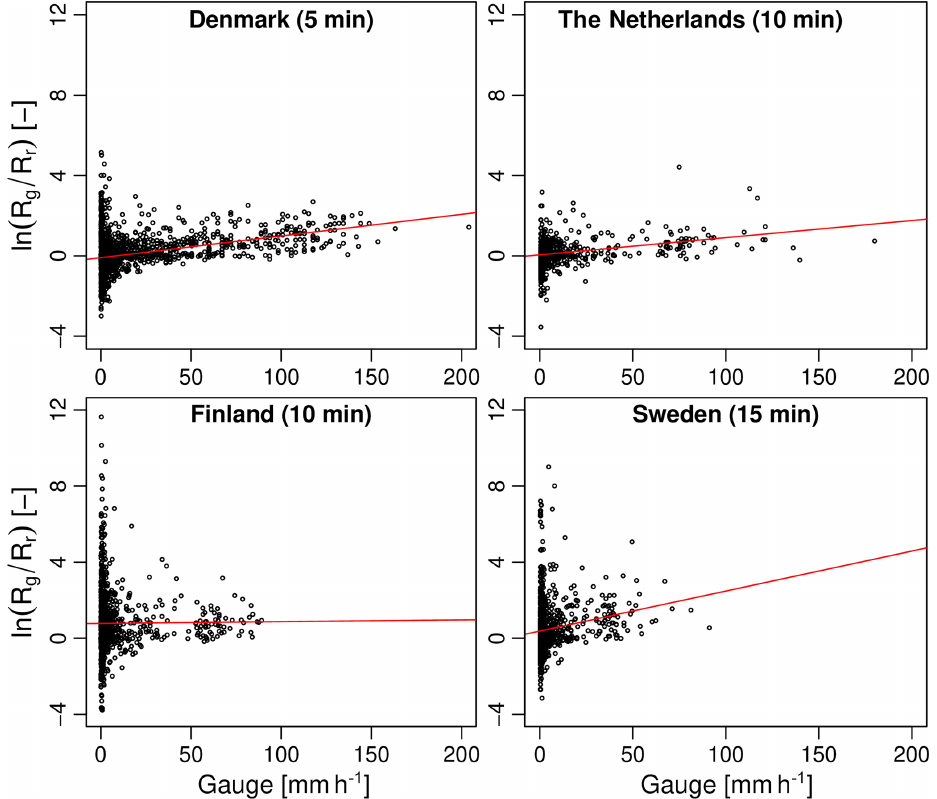
Figure 7. Log ratio of gauge over radar values as a function of rain gauge intensity (in mmh − 1 ) for each country. The red lines represent the fitted linear regression